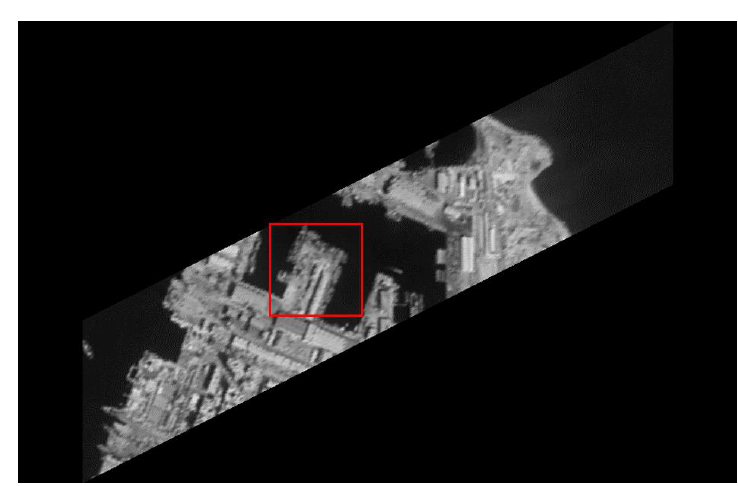
Figure 10. The seashore remote-sensing image experimental results: super-resolution images, the Figure10. Theseashoreremote-sensingimageexperimentalresults: super-resolutionimages, thechosen chosen area is an offshore structure in an Egyptian port. area is an o ff shore structure in an Egyptian